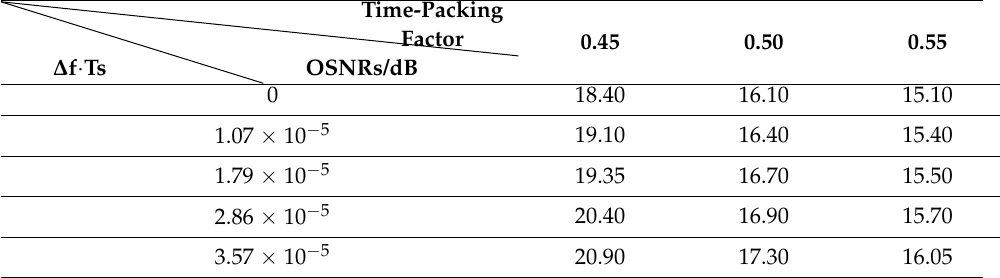
Table 1. The required OSNRs for the modified-BPS algorithm under 0, 1.07 × 10 − 5 , 1.79 × 10 − 5 , 2.86 × 10 − 5 and 3.57 × 10 − 5 ∆ f · Ts with the time-packing factor of 0.45–0.55.